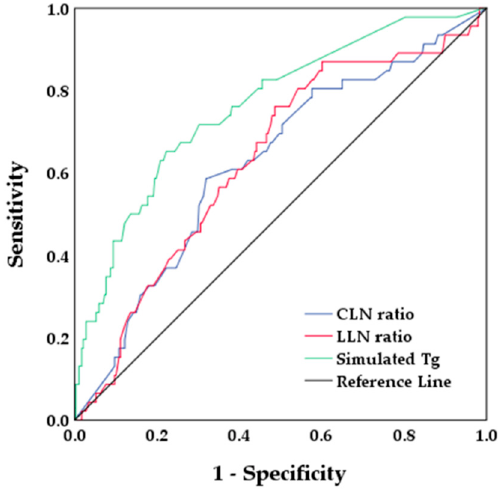
Figure 4. Receiver operating characteristic curves. Area under the curve of CLN ratio, LLN ratio, and stimulated Tg was 0.626, 0.633, and 0.763, respectively. CLN, central lymph node; LLN, lateral lymph node; Tg, thyroglobulin.